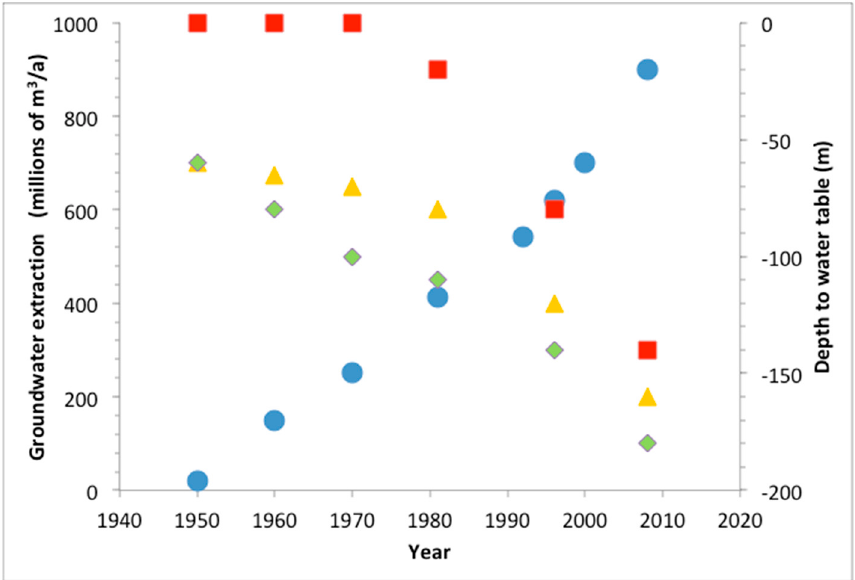
Figure 3. Evolution of groundwater extraction and annual decline of the water table at different places in the IB. Data are based on several hydrogeological studies conducted since the 1970s [2]. Blue circles represent the evolution, of groundwater extraction over time with an approximately exponential trend; the squares, triangles, and rhombuses show the decline of the water table at several locations in the aquifer. The zones with historically shallow water tables are visible near the ancient lakes and discharge areas (red squares).